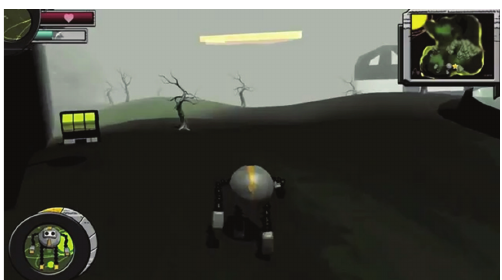
Figure 4: Screenshot of the first level, where the environment is polluted.